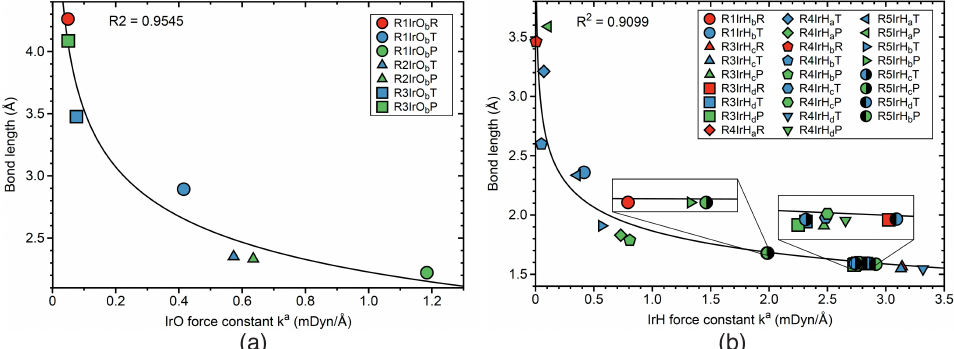
Figure 13. Correlation between bond length and the local mode force constants. ( a ) IrO bon; ( b ) IrH bonds. Labels such as R1IrO b R, R1IrO b T, and R1IrO b O indicate reactant RE (red color), TS (blue color), and product PR (green color) IrO b bond in reaction R1 . Similarly notation for reactions R2 – R5 . For the bond label description see the text. B3LYP/6-31G(d,p)/SDD(Ir) level of